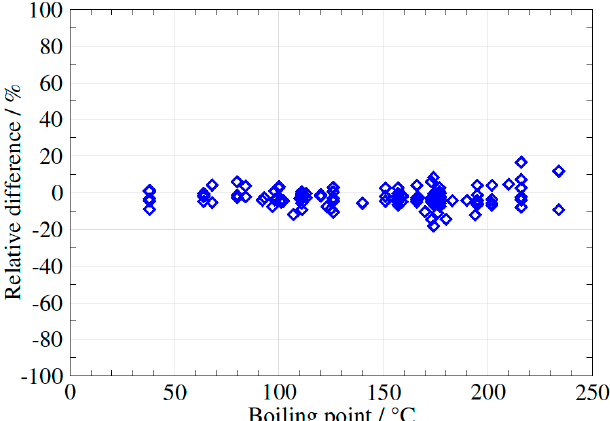
Figure 6. Difference in VOCs concentrations measured with the syringe method versus the EasyVOC method.